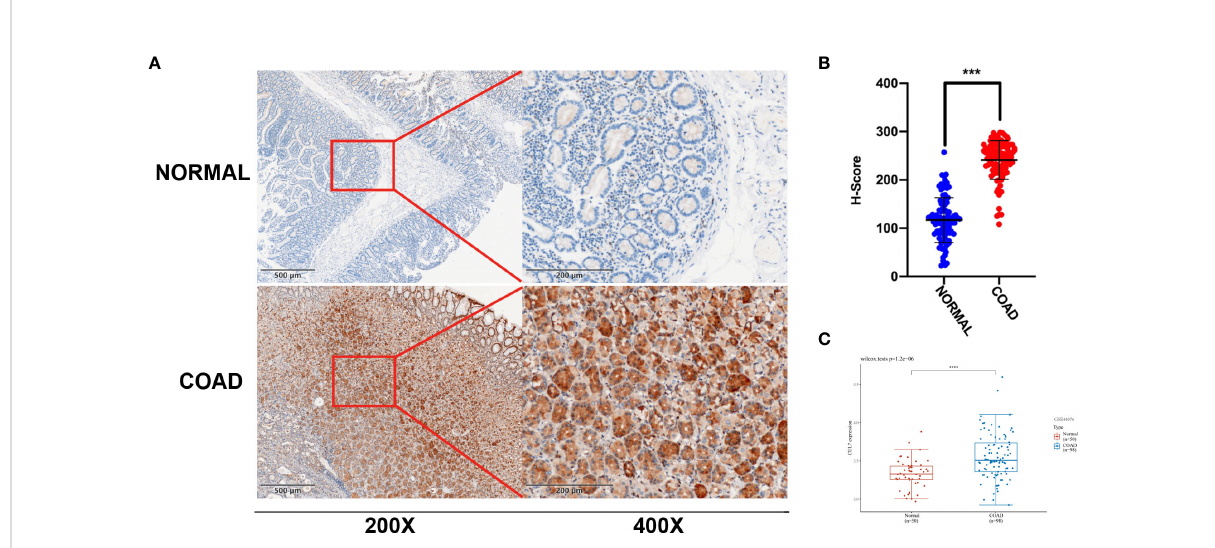
FIGURE 5 Differential expression of CUL7 (A) Immunohistochemical (IHC) staining of non-neoplastic muscle tissues and matched muscle cancer tissue sections. (n = 100; Scale bars, 500 m m and 200 m m). (B) The Scatter plot indicated the H-score of Gankyrin IHC staining intensity. (C) CUL7 expression in GSE44076. Ns, non-signi fi cant, ***P < 0.001; ****P <